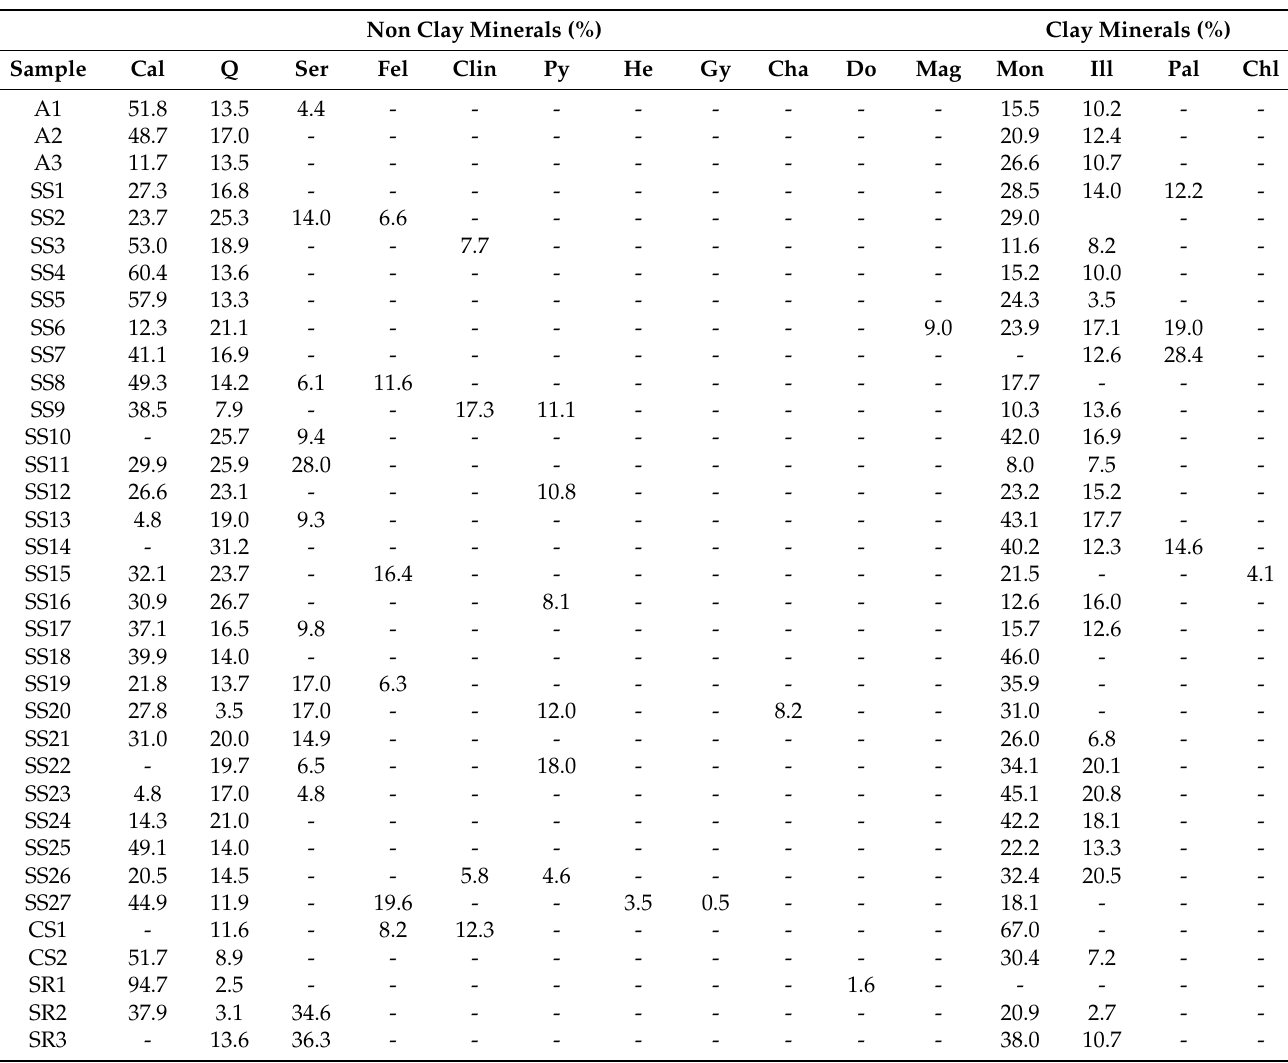
Table 3. Quantitative mineral composition of fraction < 2 mm of the investigated